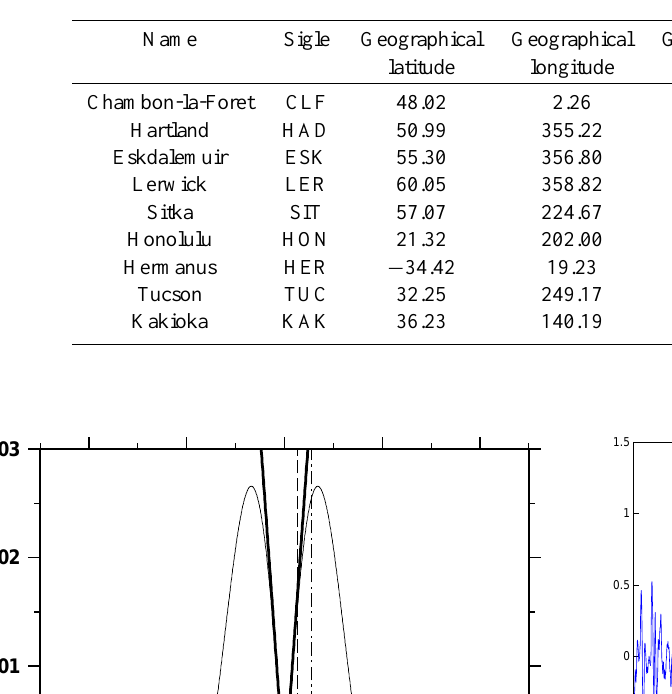
Table 1. Names, acronyms and coordinates of magnetic observatories used in the study, and years available.